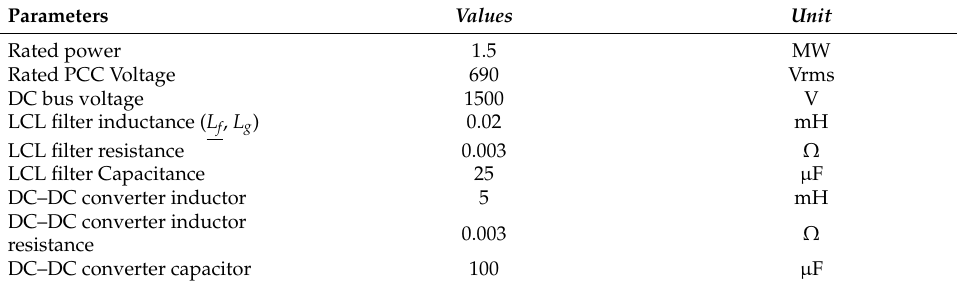
Figure 7. Illustration of EMT simulation model of a grid-connected IBR. Table 1. Simulation parameters of the EVGI system.